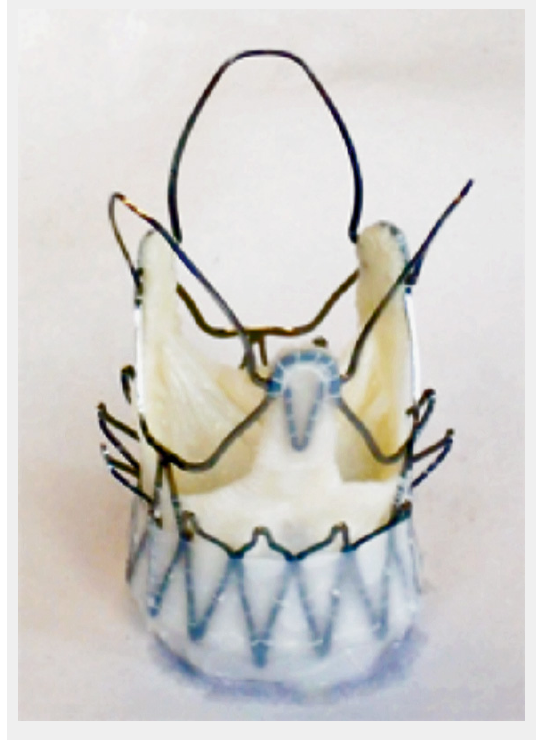
Figure 11 The stent-valve by Symetis SA, Lausanne, Switzerland.